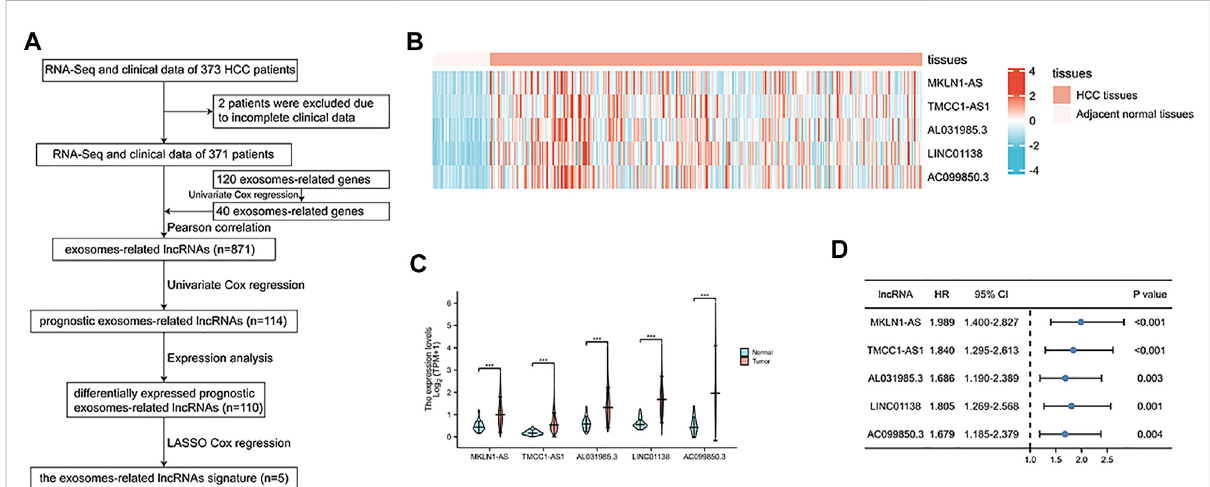
FIGURE 1 Identi fi cation of prognostic exosomes-associated lncRNAs in liver cancer patients. (A) The fl ow chart for the construction of exosome- related lncRNA signature. (B) Heatmap of 5 prognostic exosome-related lncRNAs in cancer tissues and adjacent normal tissues. (C) The expressionof5prognosticexosome-relatedlncRNAsinnormalandtumortissues. (D) UnivariateCoxregressionof5prognosticexosome-related lncRNAs. * p < 0.05; ** p < 0.01; *** p < 0.001; **** p < 0.0001.